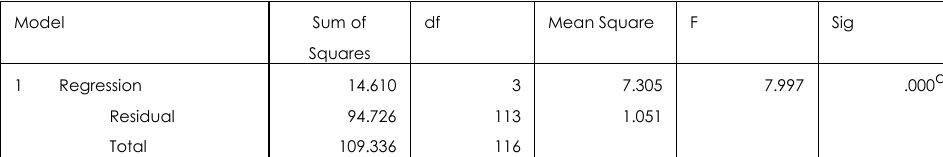
Tabel. 4 : Analisis Anova Multiple Regression